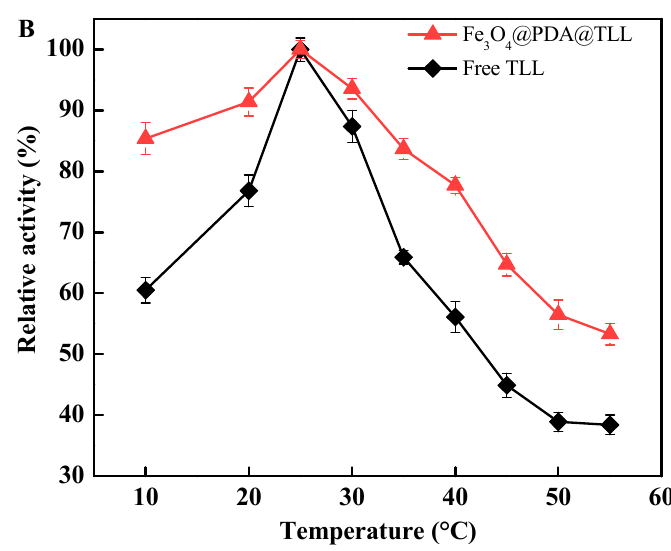
Figure 5. Effect of pH ( A ) and temperature ( B ) on the activity of free TLL and Fe 3 O 4